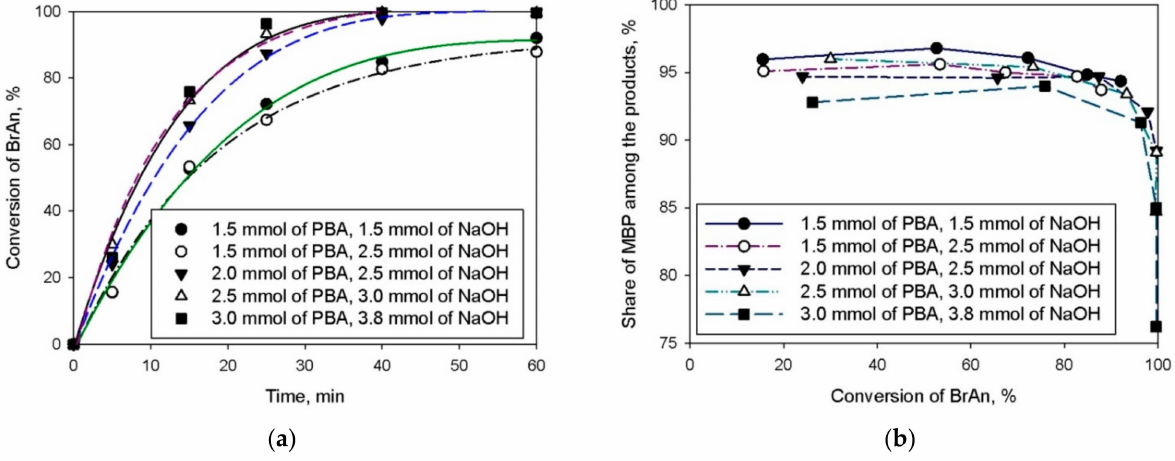
Figure 7. Influence of the amount of PBA and NaOH on the BrAn conversion vs. time ( a ) and on the “selectivity” to MBP vs. BrAn conversion ( b ); reaction conditions: 60 ◦ C, 900 rpm, and 30 mg of